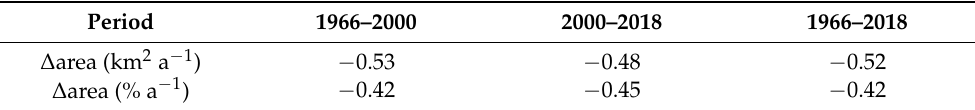
Table 3. Changes in glacier areas over the A’ny ê maq ê n